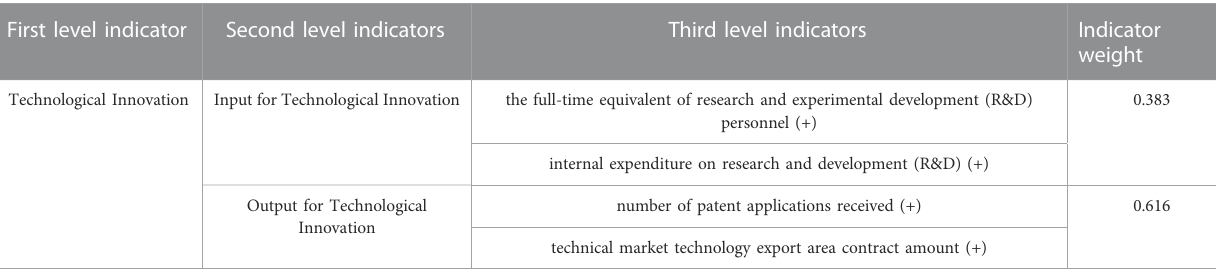
TABLE 2 Index evaluation system and weight for technological innovation. First level indicator